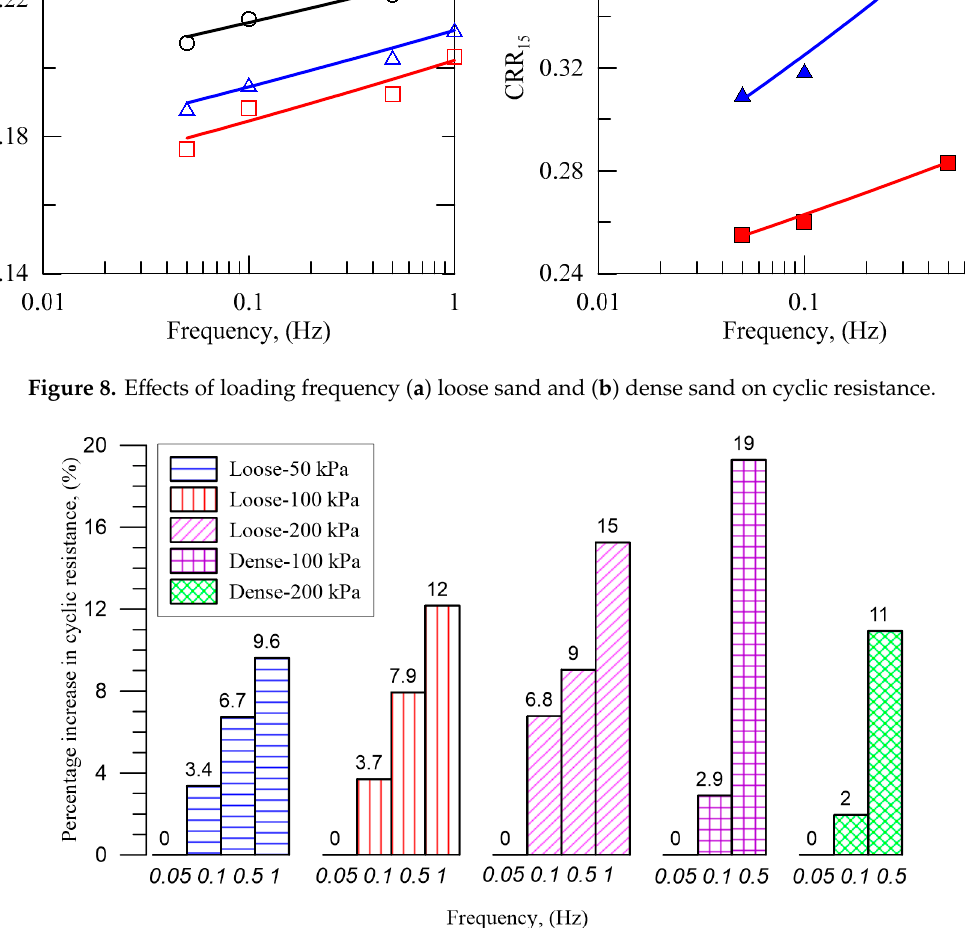
Figure 8. Effects of loading frequency ( a ) loose sand and ( b ) dense sand on cyclic resistance.